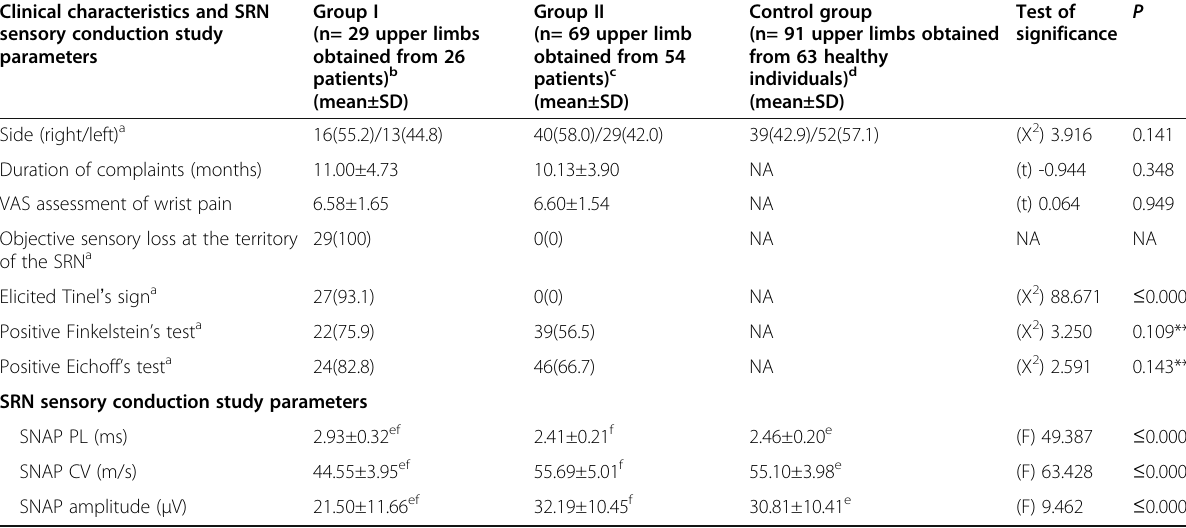
Table 3 Comparison between the two patients ’ groups and control group regarding different assessed parameters Clinical characteristics and SRN sensory conduction